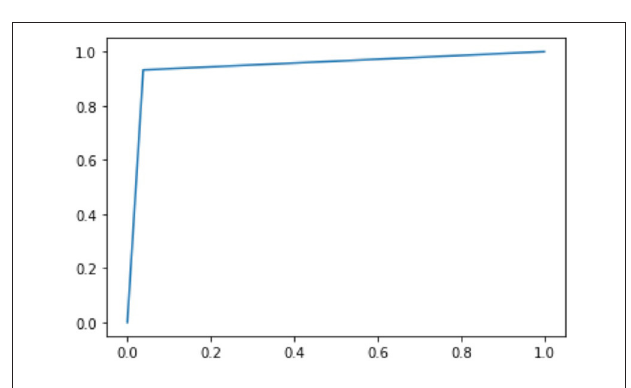
FIGURE 8 | Receiver operating characteristic curve for